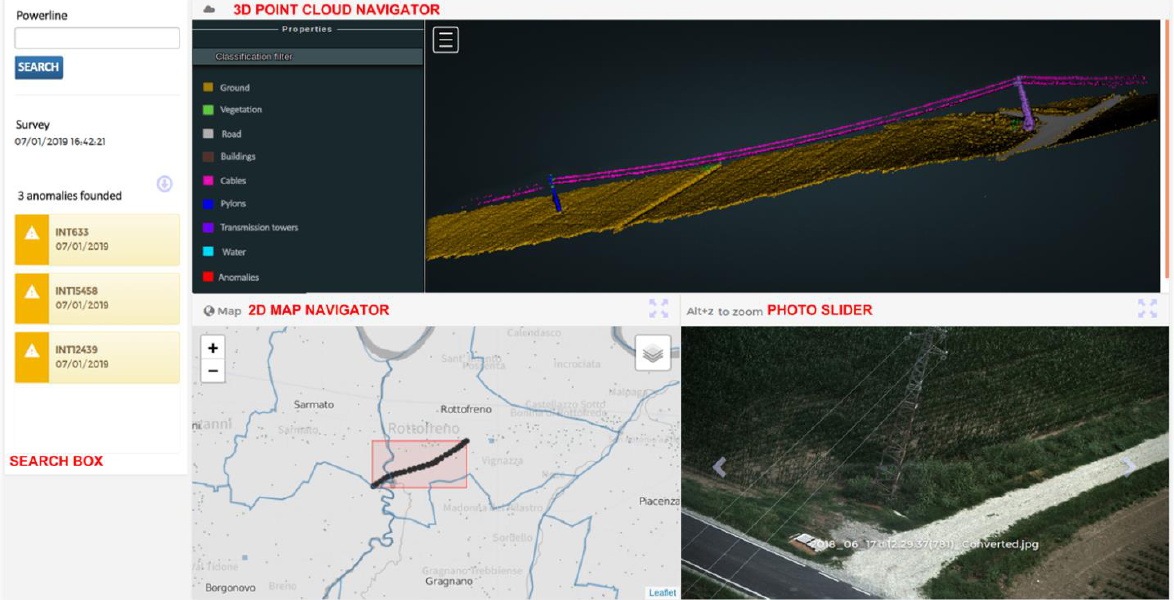
Figure 5. The user interface of the WebApp Rendering: the left panel is for searching and information display, in the other cells the 3D point cloud, map and image data are displayed.  photo slider, that shows the images used as input for the photogrammetric process. Particularly, by selecting a point in the 3D navigator, the image where that point is visible in the centre most position, is automatically displayed.